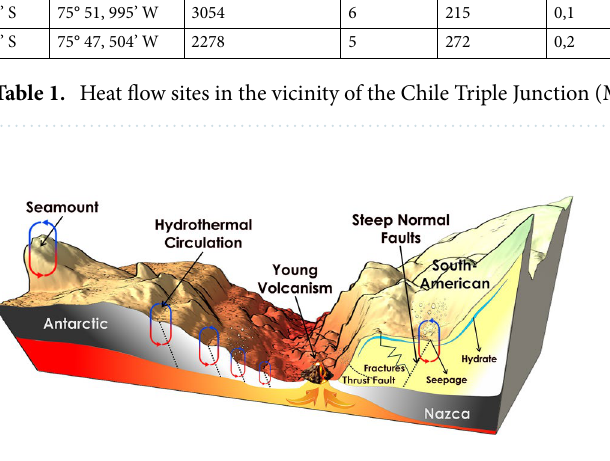
Figure 7. Graphical summary of the study area during the campaign MR18-06 showing the main features that affect the thermal regime at the Chile Triple Junction area. Figure generated using QGIS-v3.16.8 (https:// www. qgis. org/ en/ site/), labels and art were added with the software CorelDRAW Graphics Suite 2021 (https:// www. corel draw.